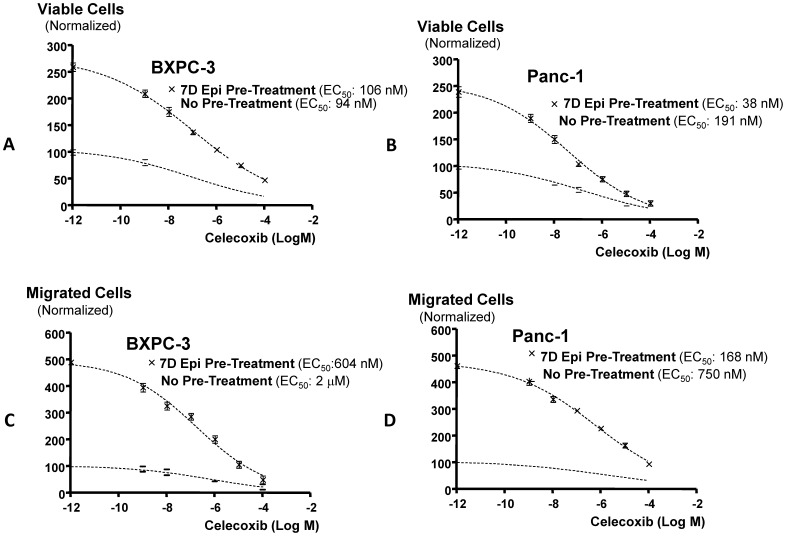
Cell proliferation and migration dose response-curves.Dose response-curves for celecoxib in Panc-1 and BXPC-3 cells in vitro in the presence and absence of pretreatment for 7 days with epinephrine (15 nM). Figures A and B show cell proliferation responses in MTT assays while Figures C and D show cell migration responses. While both cellular responses were similar among the two cell lines, EC50 values for celecoxib in Figs. B, C and D were significantly (p<0.001) lower in the cells pretreated for 7 days with epinephrine. Data points are mean values and standard deviations (n = 5). EC50 values and curve fit were established by nonlinear regression analysis for sigmoidal dose-responses.